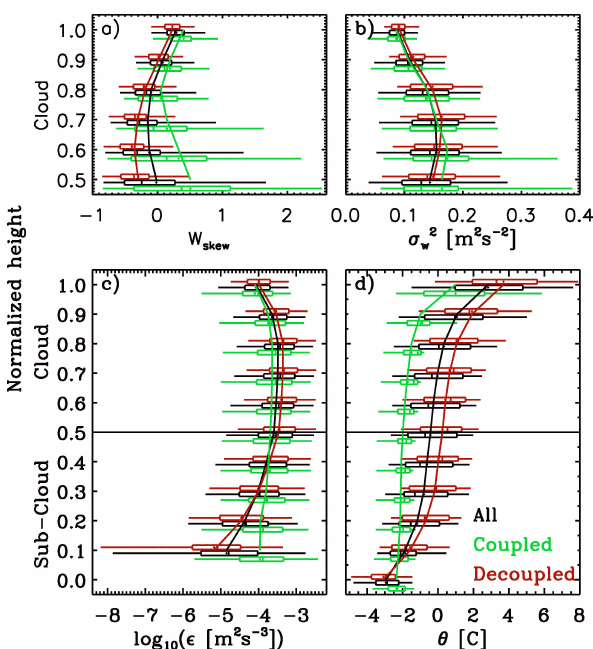
Fig. 14. Normalized statistical profiles of (a) vertical velocity skew- ness, (b) vertical velocity variance, (c) turbulent dissipation rate, and (d) 60-GHz radiometer-derived potential temperature. Black curves represent all data noted by the thick black lines at the top of Fig. 12, while the red and green curves are for the predomi- nantly decoupled and intermittently coupled time periods noted in Fig. 12, respectively. Normalization is done relative to the cloud top (1.0), cloud base (0.5), and surface (0.0) in steps of 0.1. At each normalized height level, box-and-whisker diagrams show the 5th, 25th, 50th, 75th, and 95th percentiles, while the continuous verti- cal curves represent the mean values. Statistics are computed at the same normalized heights for all data subsets, but are visualized at slightly different heights to facilitate comparisons. Since vertical ve- locity can only be determined within cloud layers, (a) and (b) only show normalized height ranges within